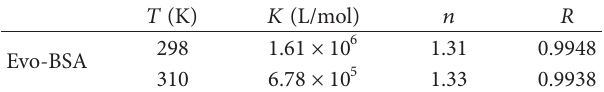
T 2: Binding parameters for BSA interaction with Evo, correlation